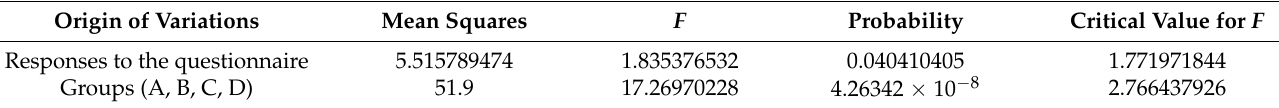
Table 7. Analysis of variance for the four groups.